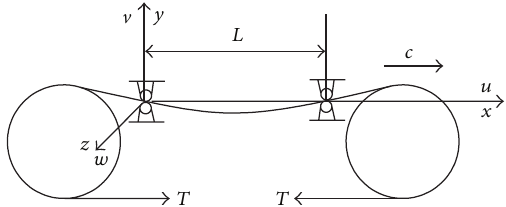
Figure 1: The model of a viscoelastic moving belt and the coordinate